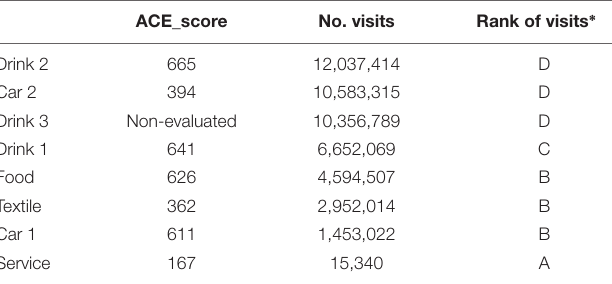
advertisements regarding number of